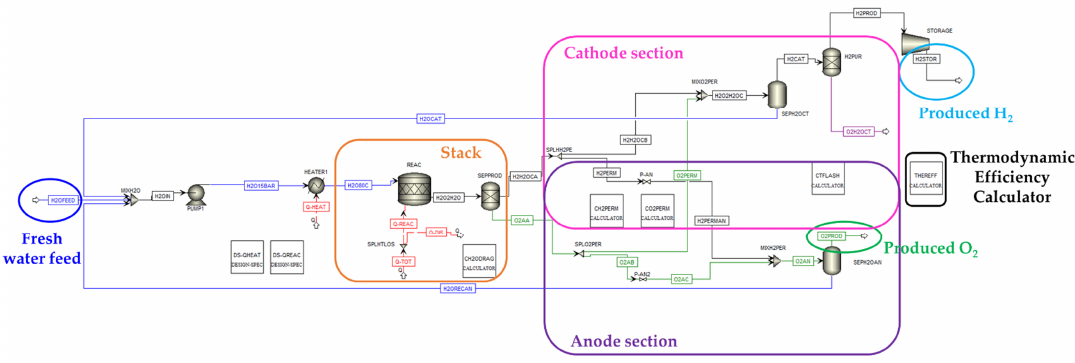
Figure 3. Aspen Plus ® flowsheet of PEM electrolysis model.